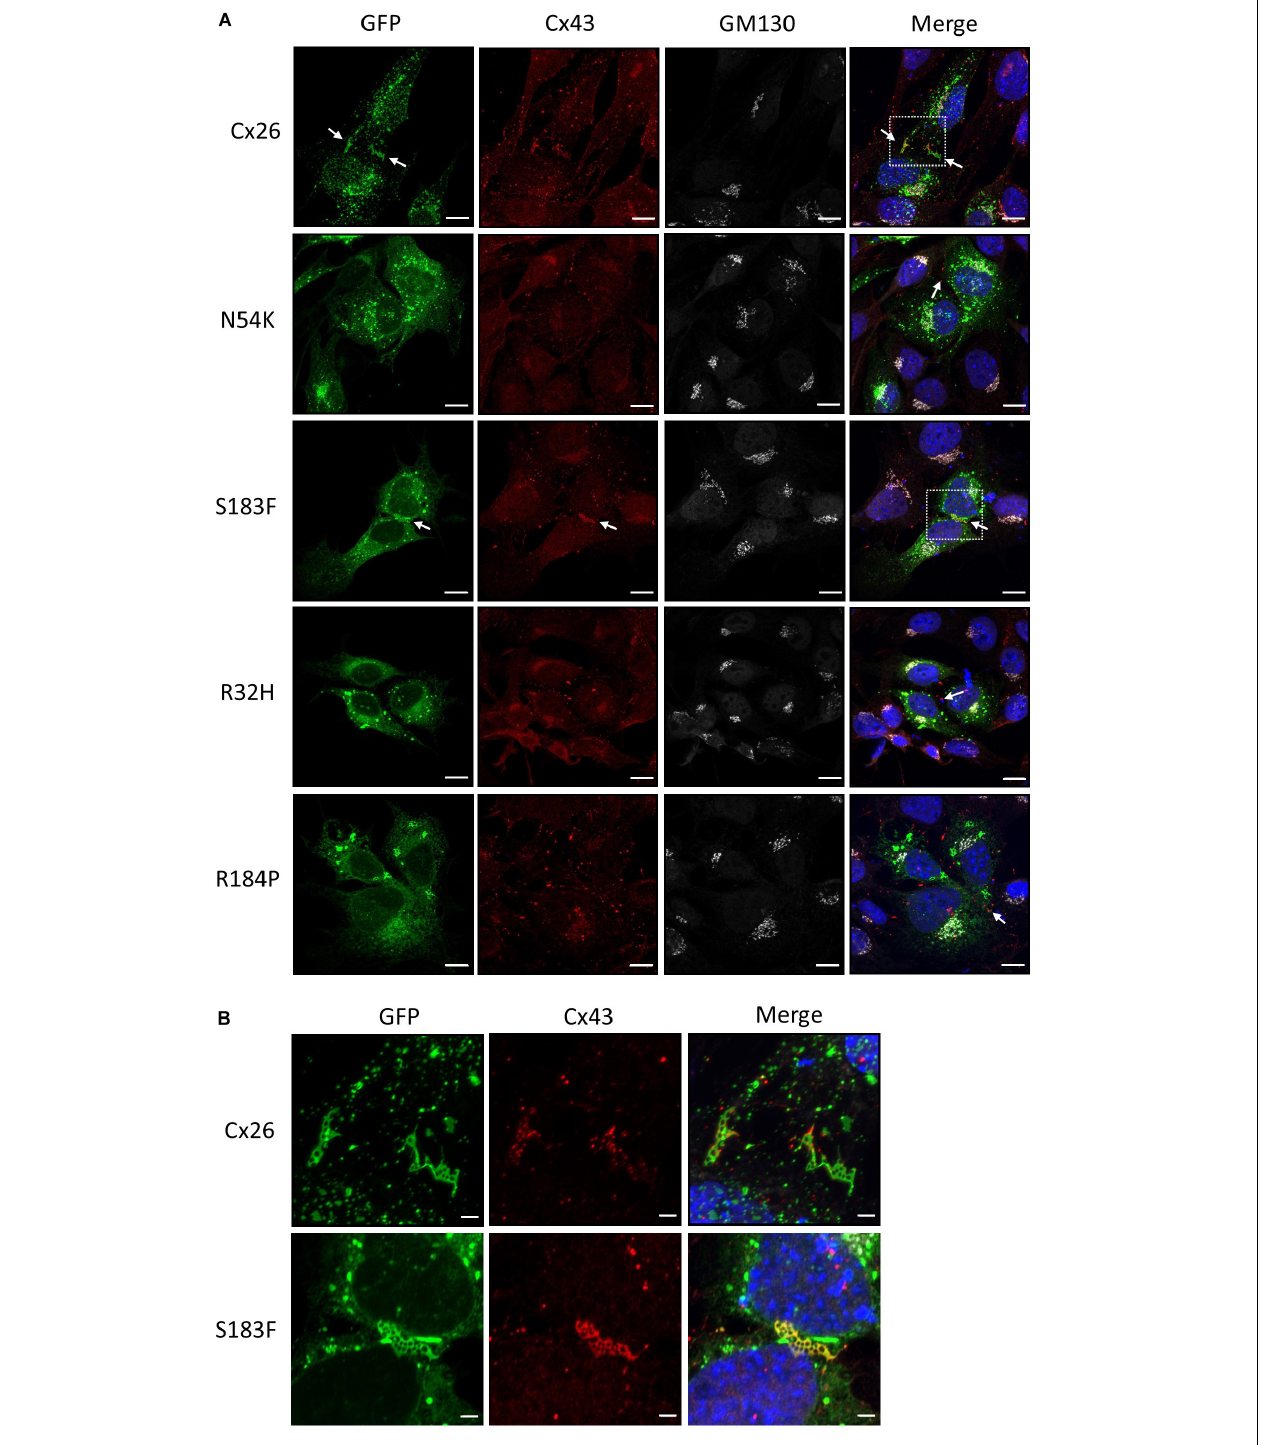
FIGURE 7 | The S183F mutant intermixes with endogenous Cx43 within the same gap junctions. (A) Representative micrographs of wild type HEI-OC1 cells expressing Cx26-GFP or Cx26 mutants, and co-immunolabeled for Cx43 (red) and GM130 (white) prior to counterstaining with Hoechst (blue). The N54K, R32H, and R184P mutants typically localize to sites that do not contain Cx43 while WT Cx26 and the S183F mutant appear to closely associate with the position of Cx43 (arrows). (B) High magnification of dashed boxed image areas in (A) revealed that WT Cx26 segregates to gap junction domains that are part of a Cx43 gap junction (note the separation of red and green signals). However, en face imaging of S183F expressing cells revealed that Cx43 and the S183F mutant fully intermixed as revealed by the yellow color. Bars = 10 µ m.